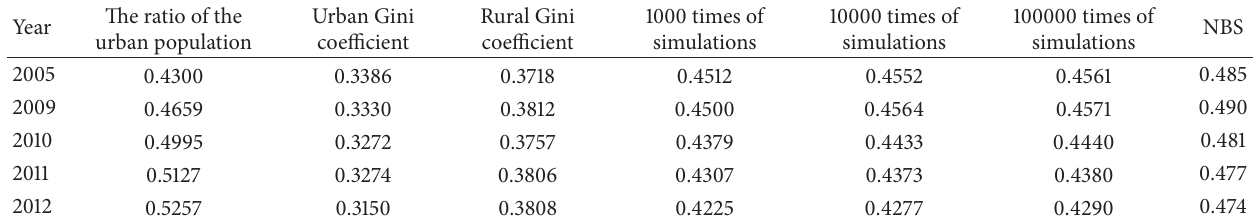
Table 4: Gini coefficient of resident income in